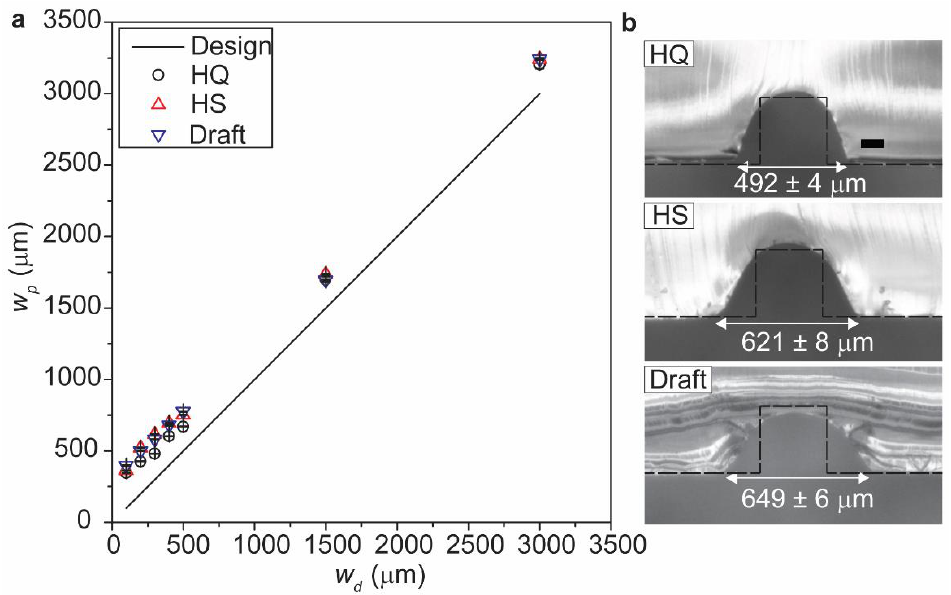
Figure 3. ( a ) Plot of the w p against w d obtained for three different layer thickness: HQ (16 µm), HS (28 µm), and Draft (36 µm). ( b ) Microscopic images showing the cross-section of the designed and printed cuboid-shaped structures replicated in PDMS for the three different modes of printing. The microstructures were with w d = h d = 300 µm. Scale bar = 100 µm.